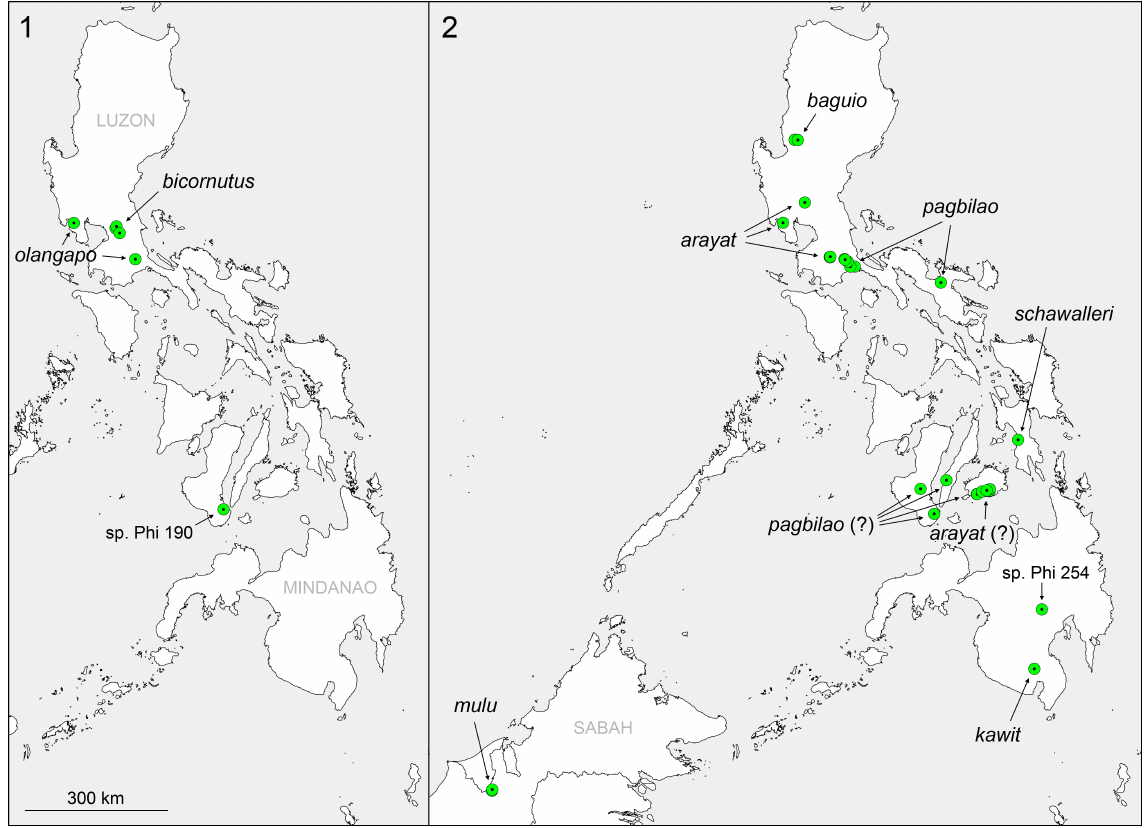
Figs 1–2. Known distributions of the two subgroups of the Pholcus bicornutus species